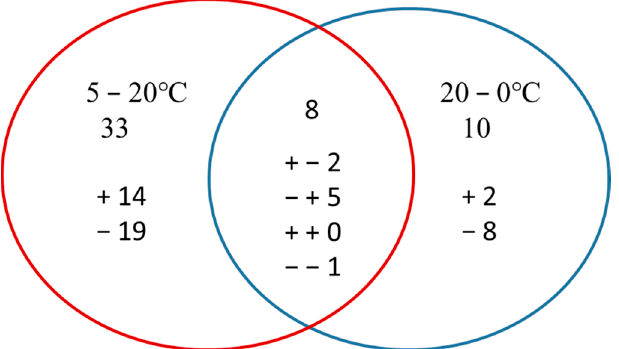
Figure 4. Venn diagram of differentially abundant proteins that were up or downregulated by an increase or decrease in temperature. The “+” and “ − ” indicate up and downregulated proteins, respectively. “+ − 2” means that, among the eight proteins, two proteins were upregulated in 5–20 °C while downregulated in 20–0 °C.